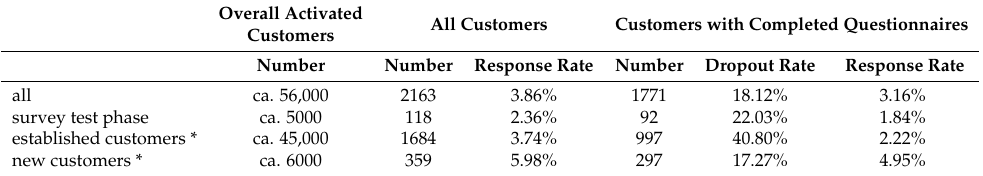
Table A2. Suvey response rates. Source: Own